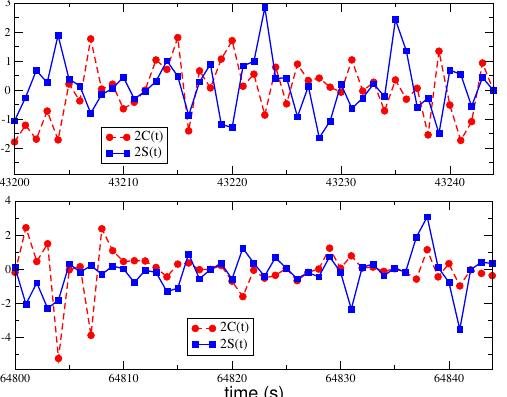
Figure A1. For (cid:101) v as in Equation (59) and χ = 2, we report in units 10 − 15 two typical sets of 45 s for the two functions 2 C ( t ) and 2 S ( t ) of Equation (A2). The two sets belong to the same random sequence and refer to two sidereal times that differ by 6 h. The boundaries of the stochastic velocity components Equations (A11) and (A12) are controlled by ( V , α , γ ) CMB through Equations (A5) and (A15). For a laser frequency of 2.8 · 10 14 Hz, the range ± 3.5 · 10 − 15 corresponds to a typical frequency shift ∆ ν in the range ± 1 Hz, as in our Figure